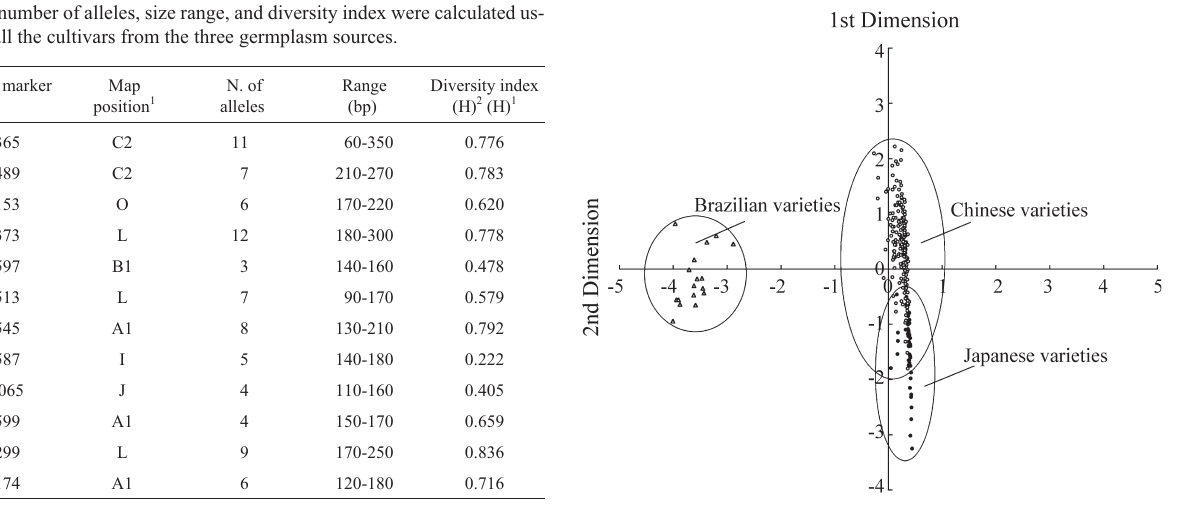
Figure 1 - Two-dimension Quantification Theory III analysis scatter plot of 272 soybean cultivars. Circles indicate the distributions of the three ge- netic